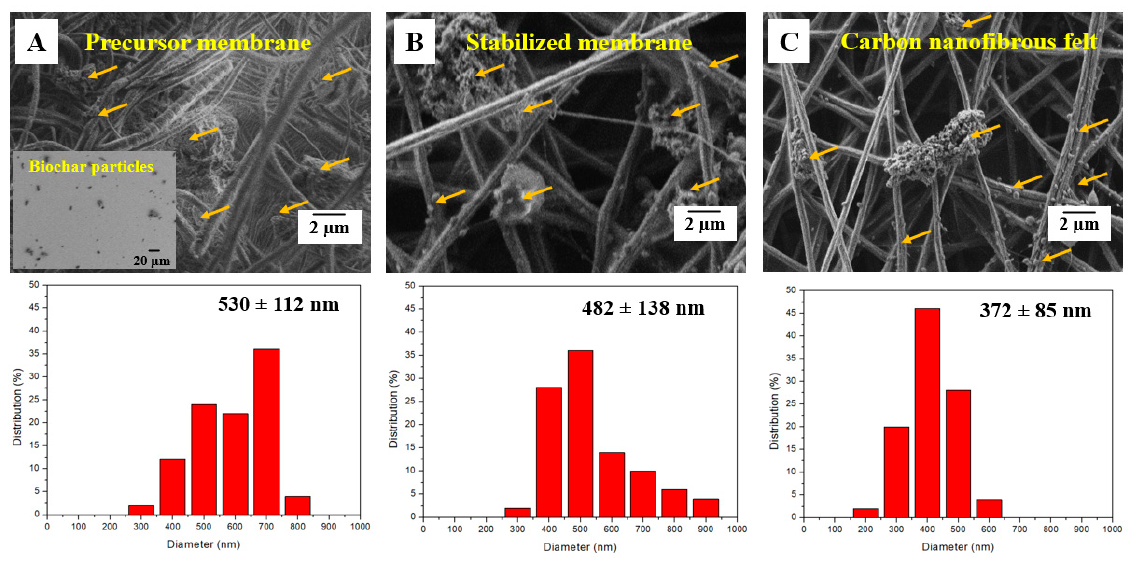
Figure 3. Scanning electron microscopy (SEM) images acquired from the ( A ) precursor membrane, ( B ) stabilized membrane, and ( C ) the resulting carbon nanofibrous felt, respectively, and their size distribution. The insert of ( A ) shows the SEM image of biochar particles. The arrows indicate the biochar particles that were enwrapped within the nanofibrous membrane/felt.